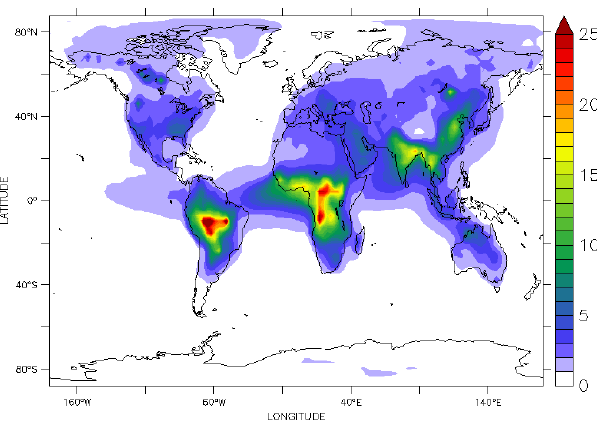
Figure 3: Modeled average surface concentration of total OA (μg m -3 ) during the years 2005- 1202 2009. 1203 Figure 3. Modeled average surface concentration of total